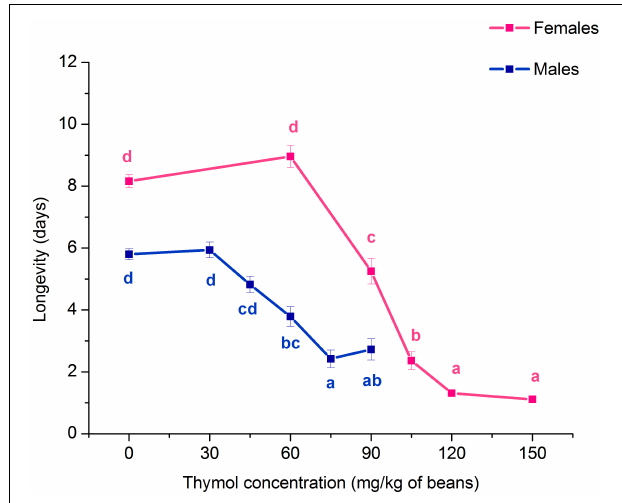
FIGURE 2 | Changes in longevity of Acanthoscelides obtectus females and males (means ± SE for 8 replicates) in response to chronic exposure to thymol treated bean seeds. Significant differences among experimental groups within each sex are marked with different letters (a - d) (Dunn’s post-hoc test, p <